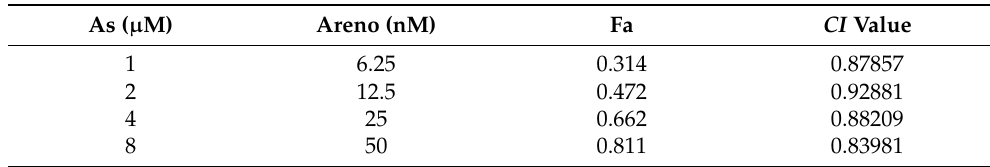
treatment for 48 h, cell viability was determined by CellTiter-Glo Luminescent Cell Viability assay. Relative cell viability was calculated as the ratio of the luminescence intensity of each treatment group against those of the corresponding untreated control group. Data are shown as the means ± SD from more than three independent experiments. ‡, p < 0.0001 vs. each alone. ( B , C ) Combination of As III and arenobufagin exerted synergistic effects on U-87 cells, as reflected by the median-effect method of Chou. The dose-effect curves of single or combined drug treatment analyzed by the median-effect method demonstrated that the values of combination index ( CI ) were < 1, indicating that the two drugs performed in a synergistic manner. As, As III ; Areno, arenobufagin; Fa, the effect levels; CI , combination index. Table 1. CI values of As III at concentrations in combination with Areno in U-87 cells. CI < 1 represents synergism. As, As III ; Areno, arenobufagin; Fa, the effect levels; CI , combination index.